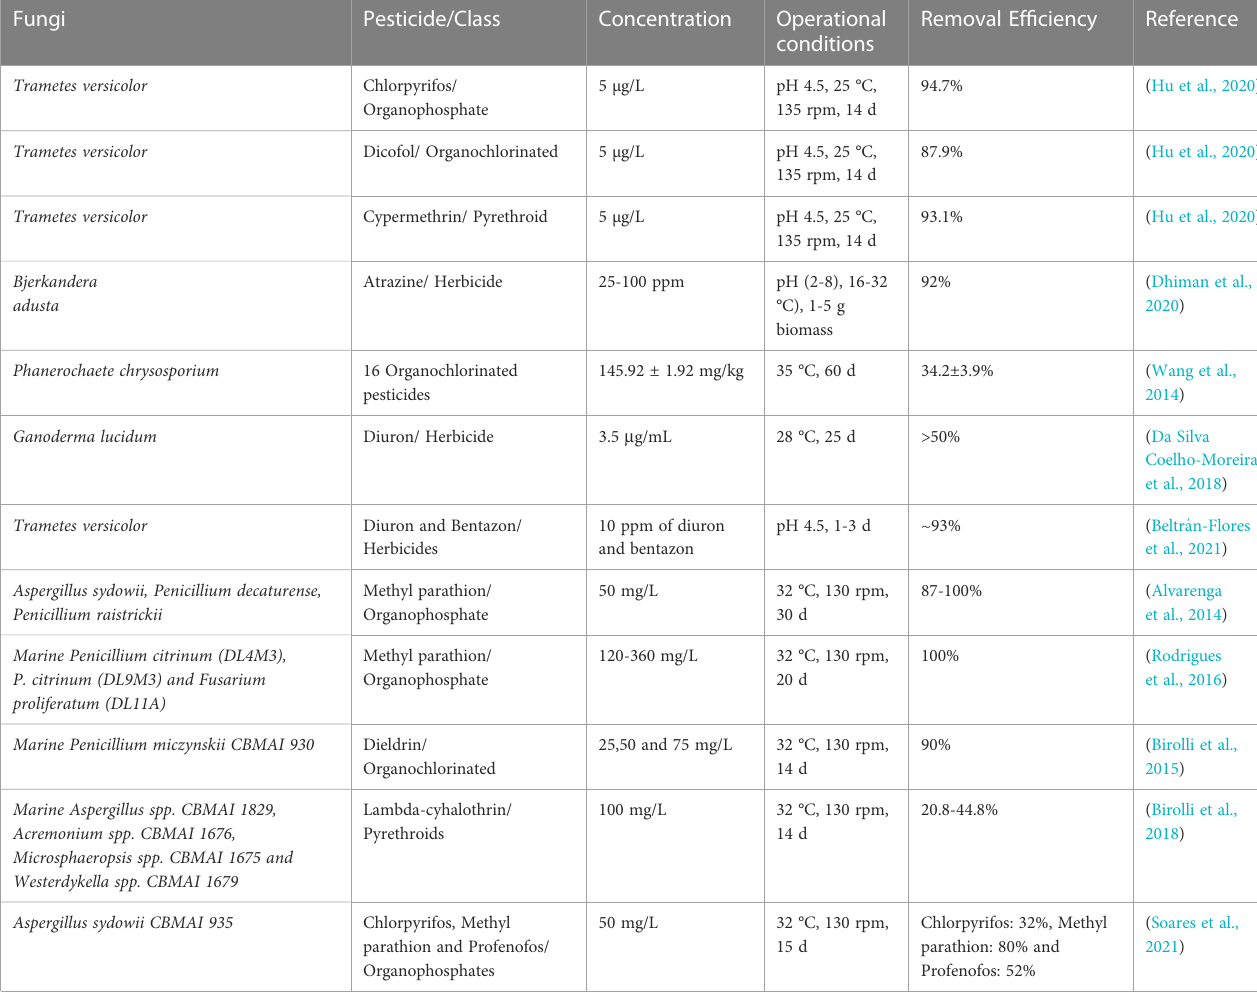
TABLE 2 Examples of application of fungi for the biodegradation of pesticides. Fungi Pesticide/Class